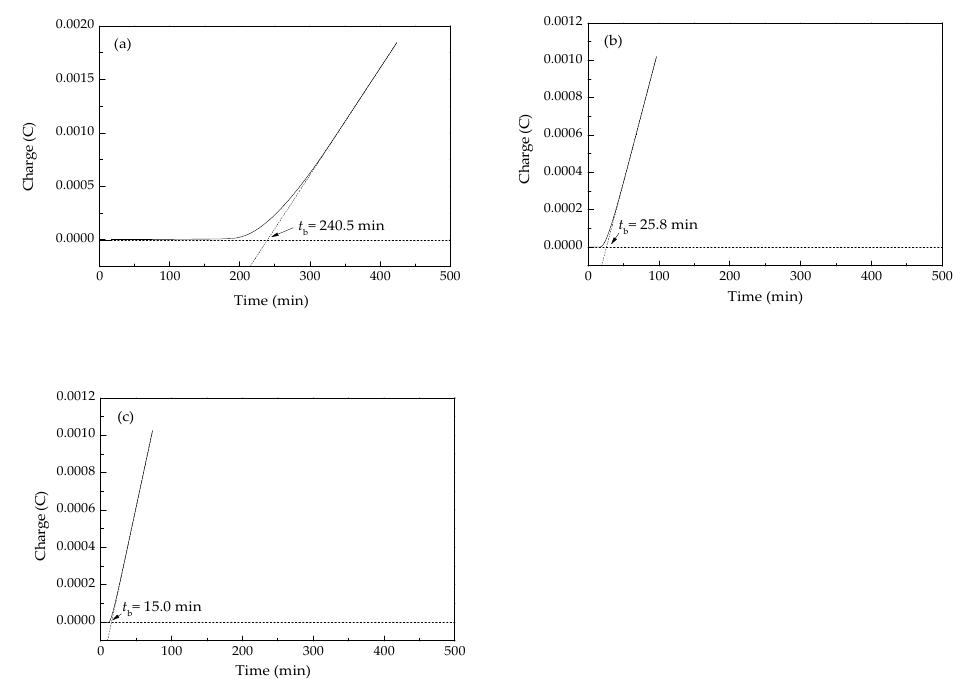
Figure 5. Charge–time curves of hydrogen permeation test: ( a ) HR sample; ( b ) EF1 sample; Figure 5. Charge – time curves of hydrogen permeation test: ( a ) HR sample; ( b ) EF1 sample; ( c ) EF2 ( c ) EF2 sample. Table 3. Hydrogen permeation parameters of HR, EF1, and EF2 samples.